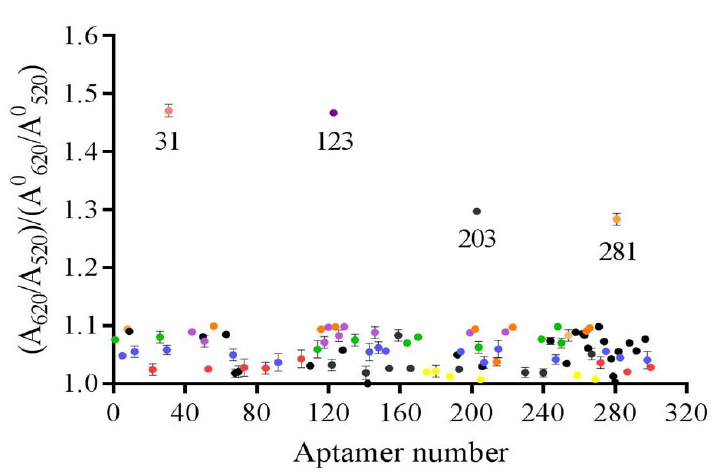
Figure 2. Preliminarily selection of active aptamers using the AuNPs colomertric assay.